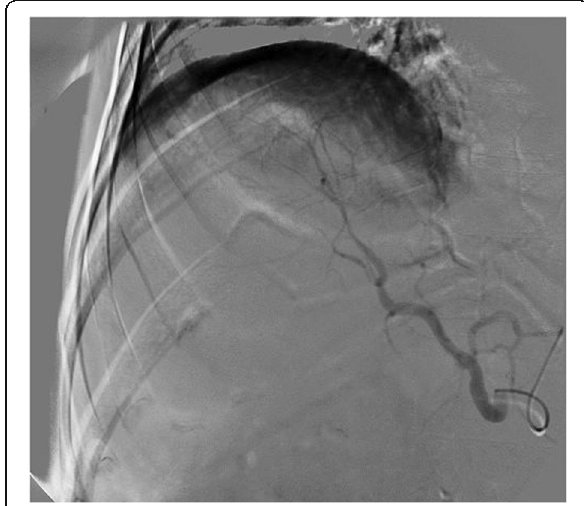
Fig. 5 Digital subtraction angiography (DSA) shows Cobra C2 5Fr catheter in mesenteric artery branch. Accessory right hepatic artery, increased in diameter, acts as anarchic vascularization towards the liver